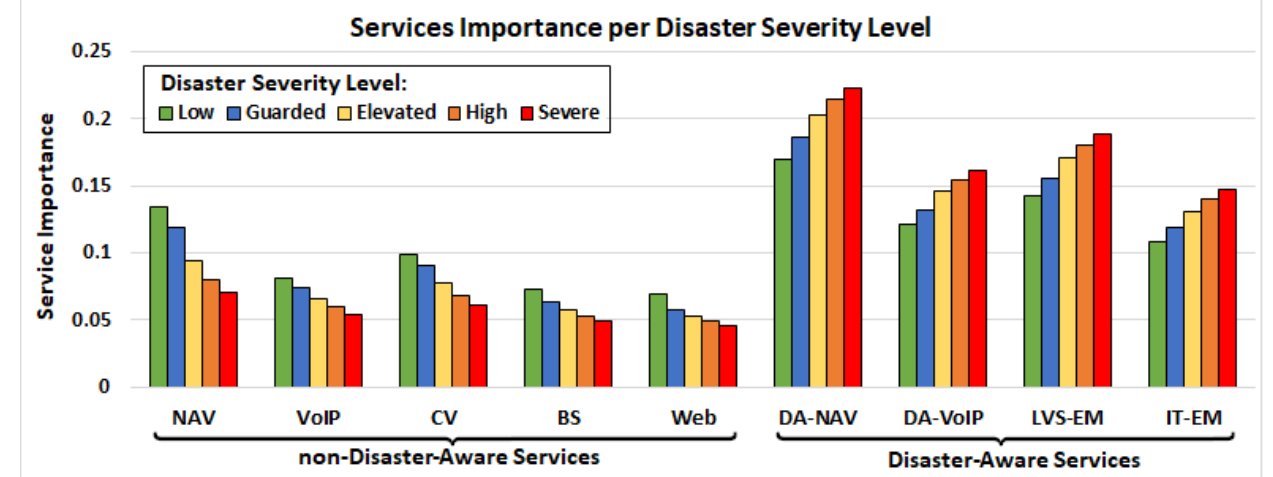
Figure 15. The importance of each service with respect to the disaster severity level.